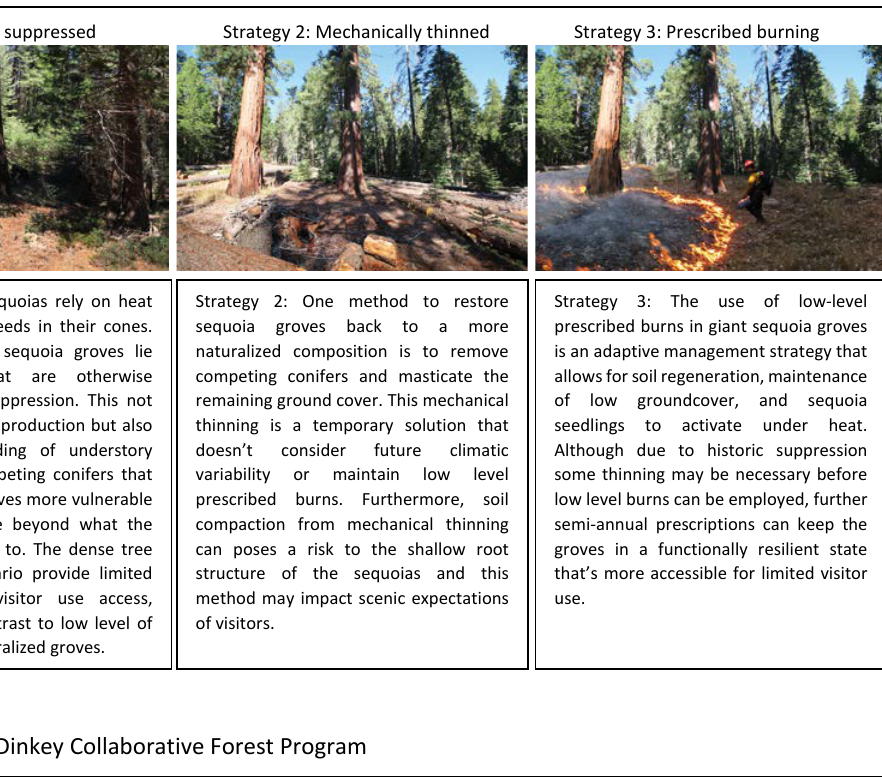
Fig. A1.9 - Site 9: Dinkey Collaborative Forest Program